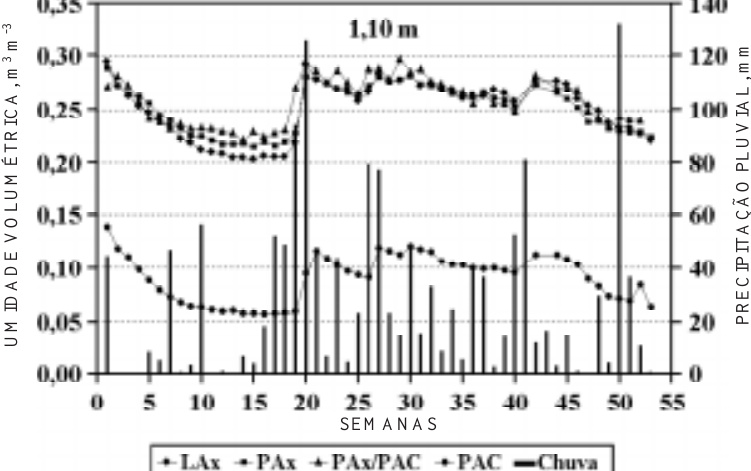
Figura 7. Variação da umidade nos solos Latossolo Amarelo argissólico (LAx), Argissolo Amarelo (PAx), solo transicional PAx/PAC e Argissolo Acinzentado (PAC), nas 53 semanas de avaliação, na profundidade de 1,10 m, e precipitação pluvial no período, em uma toposseqüência em tabuleiro do estado da Bahia.